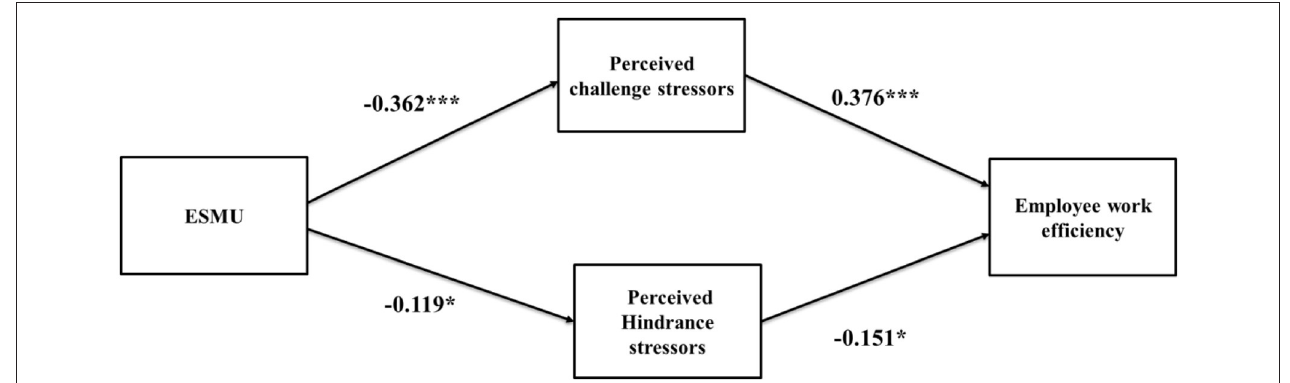
FIGURE 1 | Structural model. * p < 0.05, ** p < 0.01, *** p <